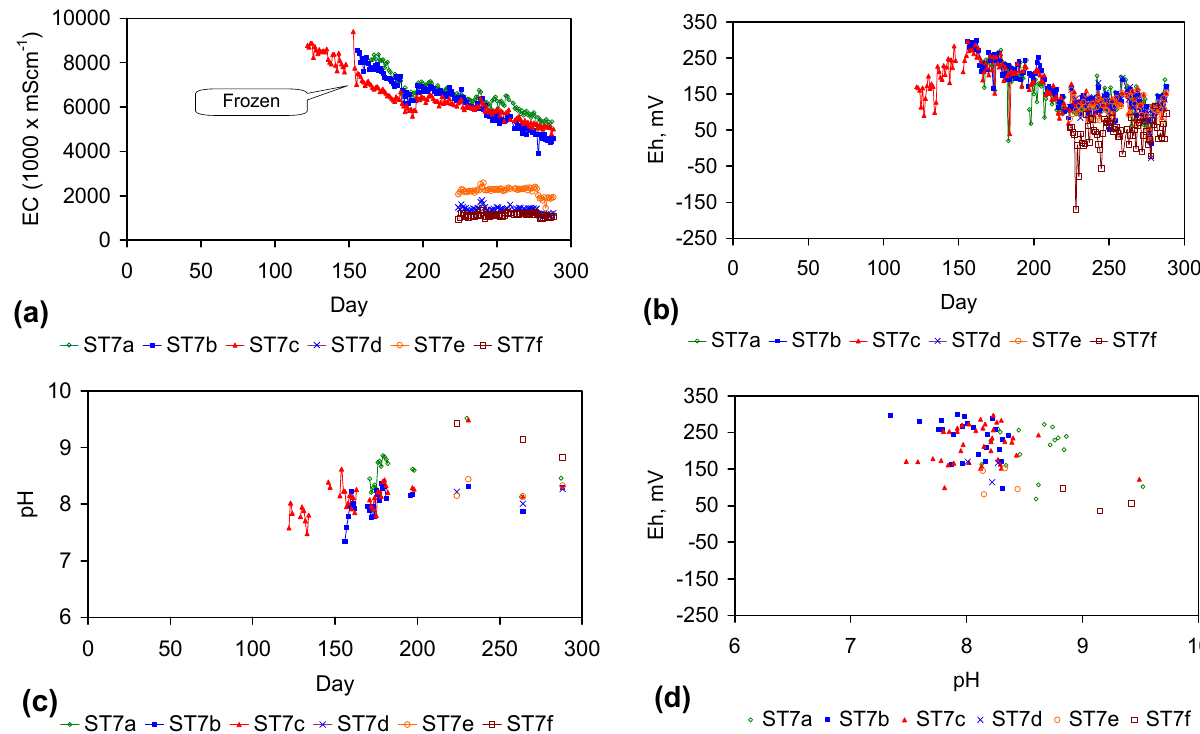
Figure C17. ( a ) EC vs. day; ( b ) Eh vs. day; ( c ) pH vs. day; ( d ) pH vs. Eh. Reactor Size: 0.3 L; Feed Water volume: 0.2 L.